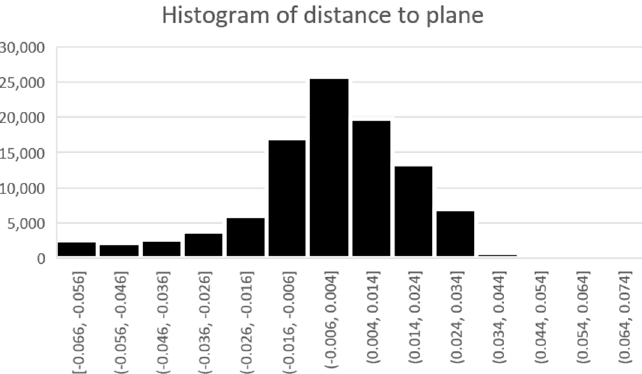
Figure 16. Histogram of distance to plane.